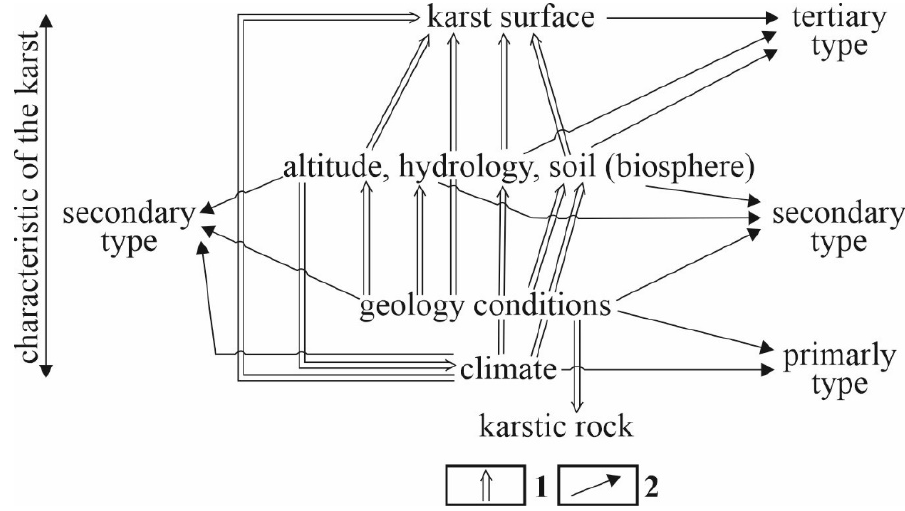
Figure 5. Interaction of factors determining karst types and their role in the development of karst types of various orders. Legend: 1. Interaction of the determining factors, 2. Karst type developed by a given determining factor. Table 3. Some examples for the classification of karst